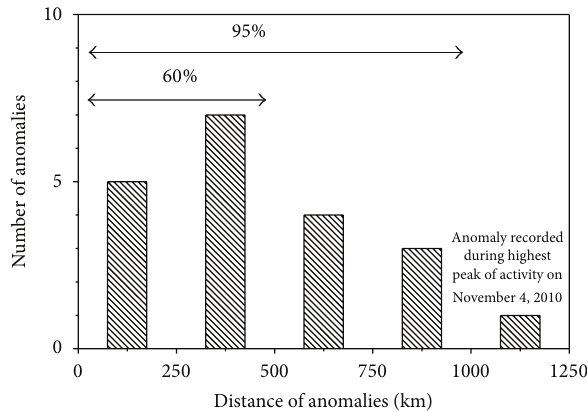
Figure 10: Distribution of the ionospheric anomalies versus the distancebetweenthefootprintofthesatelliteandthevolcanoduring Merapi eruption (September 1 to November 30, 2010).